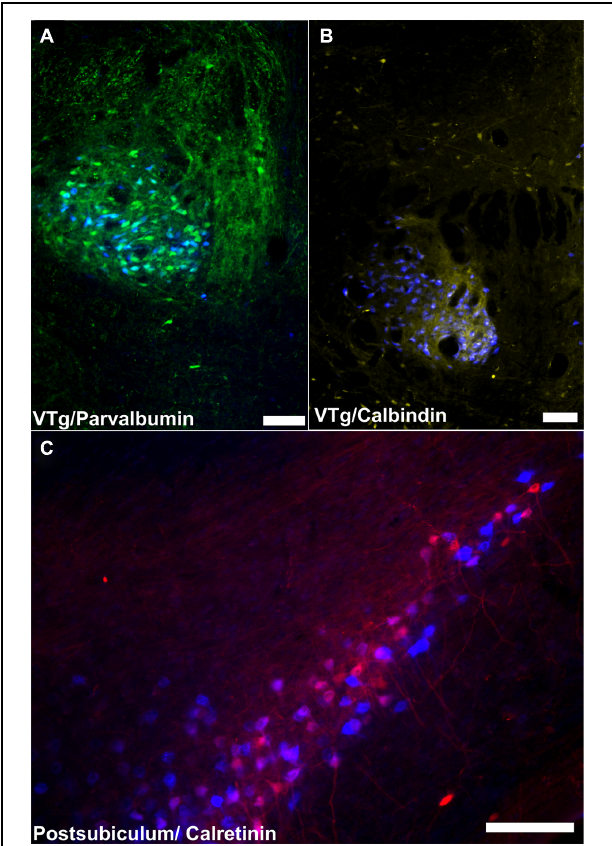
FIGURE 12 | Summary of calcium binding immunoreactivity in mammillary body inputs. (A) A considerable proportion of retrogradely labeled cells in the VTg were found to co-localize with PV neuronal immunofluorescence; (B) CB immunoreactive neurons in VTg were also found to co-localize with retrogradely labeled Fast Blue cells; (C) : Retrogradely labeled Fast Blue neurons were found to co-localize with a dense, localized CR immunoreactive neuronal population in layer III of the postsubiculum. Scale bars: 100 µ